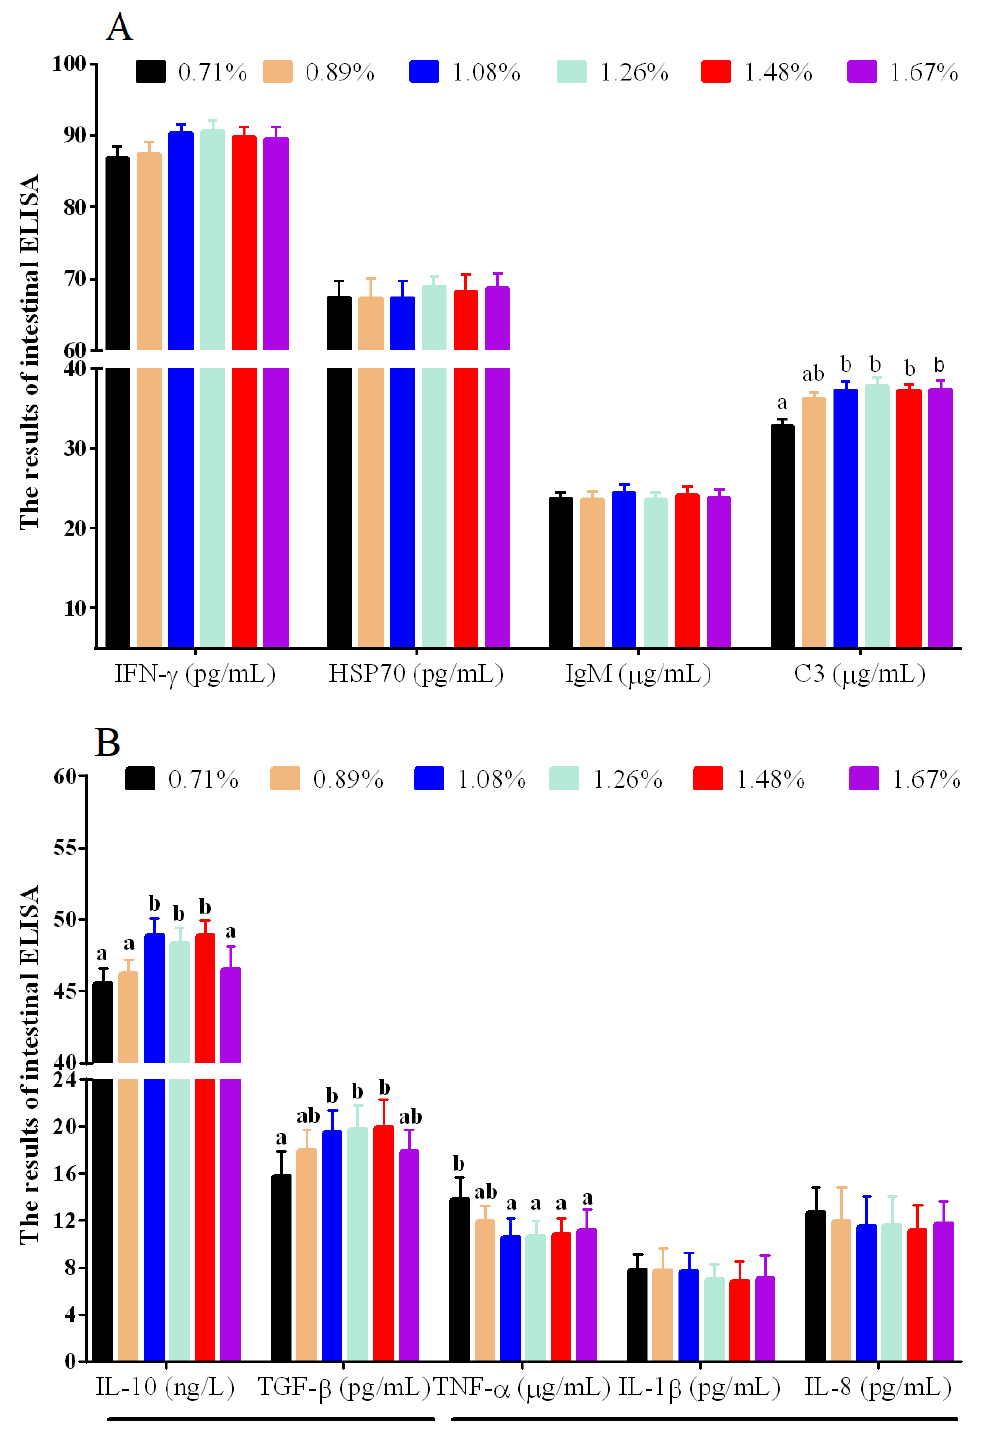
Figure 3. The results of immune cytokines of intestinal ELISA against graded different levels of dietary histidine. ( A ) showed the results of IFN- γ , HSP70, IgM and C3. ( B ) showed the results of IL-10, TGF- β , TNF- α , IL-1 β and IL-8. Data are presented as mean ± standard deviation ( n = 3 × 3). Values with different alphabetical superscripts above bars are significantly different ( p < 0.05).